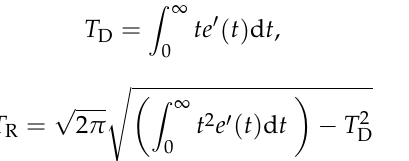
Equations (1) and (2) give the first order and second order moments of e (cid:48) ( t ) when e (cid:48) ( t ) is approximated by a Gaussian function in the time domain. The first and second